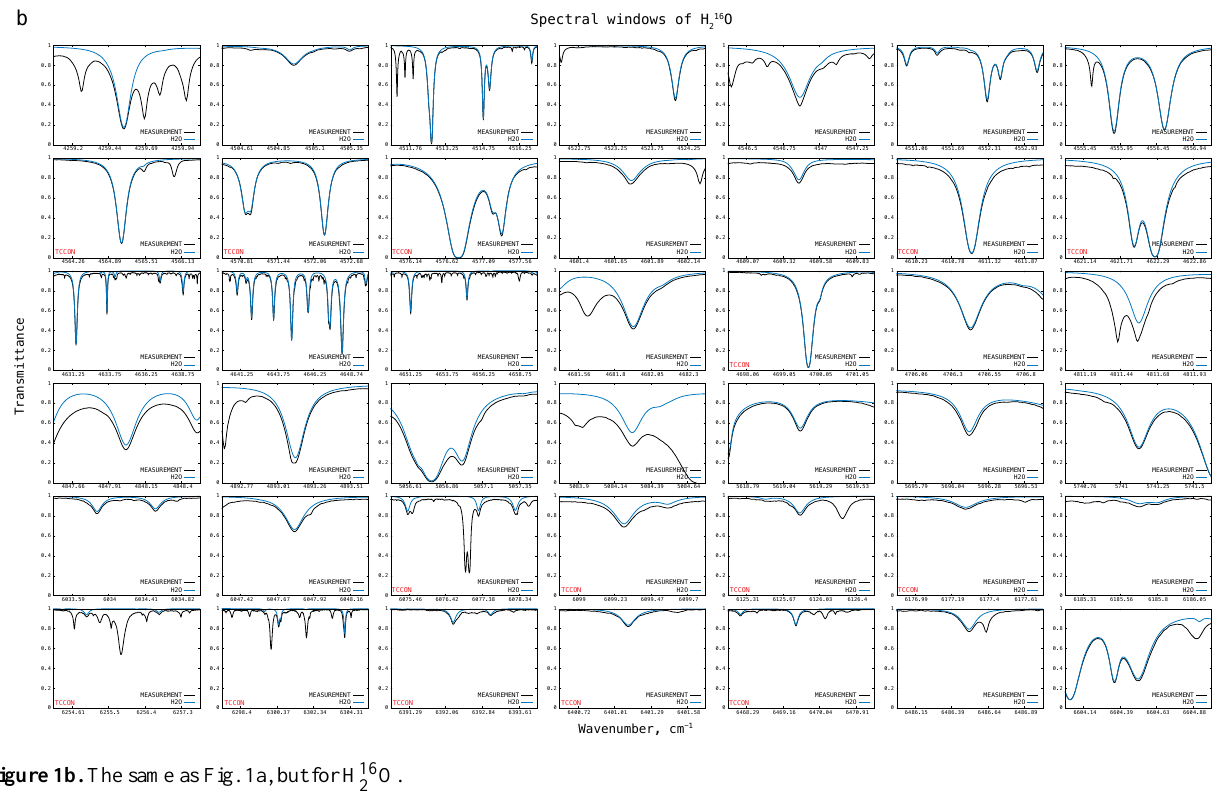
Figure 1b. The same as Fig. 1a, but for H 16